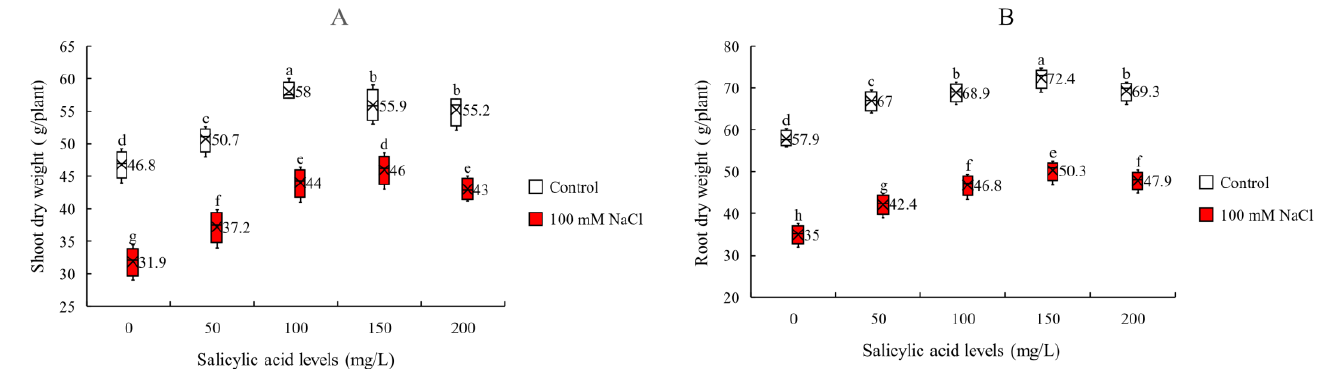
Figure 5. ( A ) shoot dry weight (SDW) and ( B ) root dry weight (RDW) of sorghum plants for interaction of SA treatments × salinity (100 mM NaCl) in four repetitions at fifty percent flowering stage. Different letters indicate significant differences by HSD at p < 0.05. The data for analysis are given in Table S1.